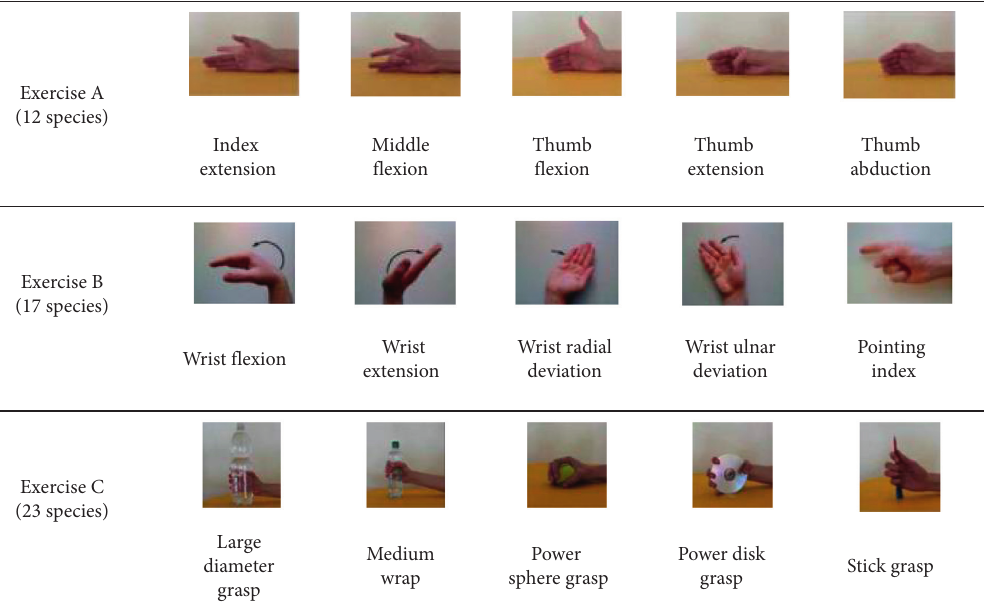
Figure 4: Partial action diagram.